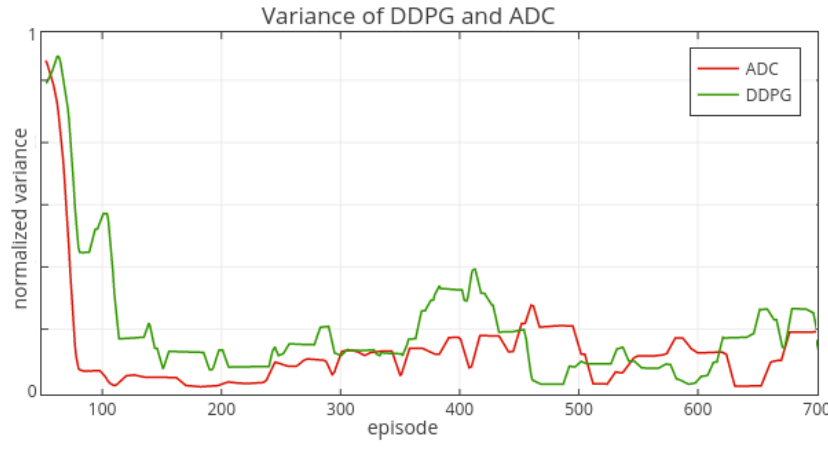
Figure 5. The variance of DDPG and ADC’s